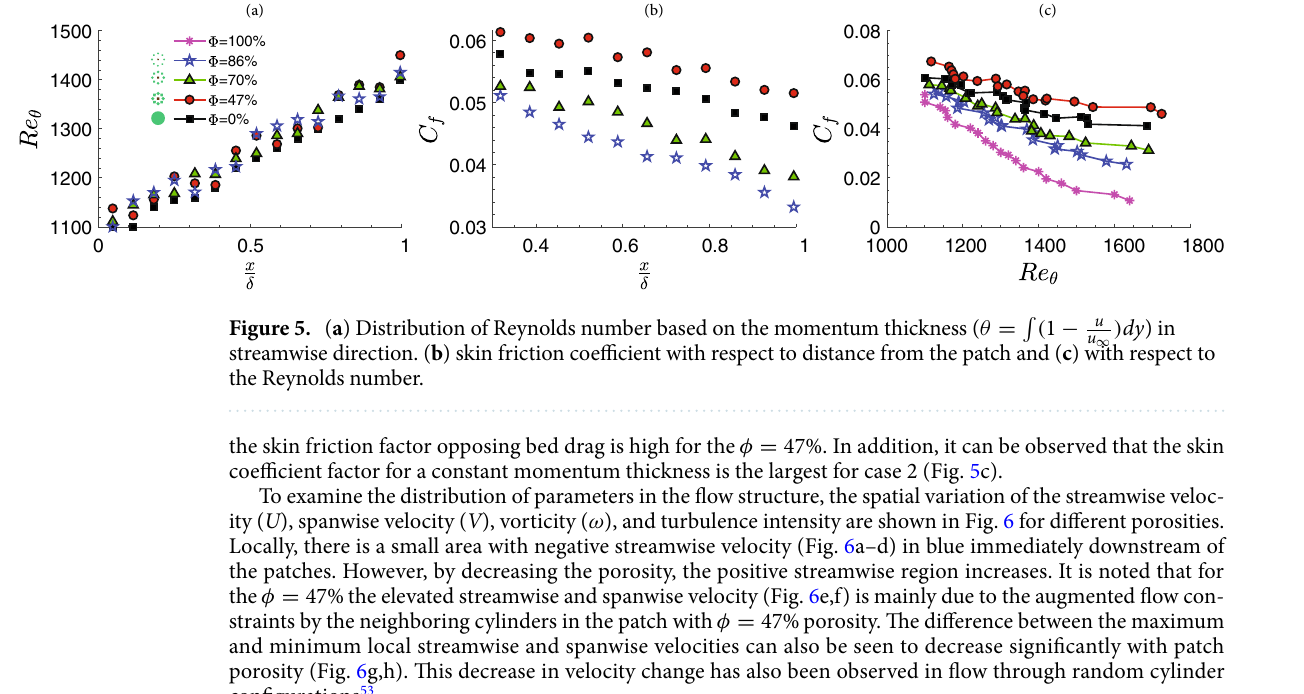
Figure 5. ( a ) Distribution of Reynolds number based on the momentum thickness ( θ = streamwise direction. ( b ) skin friction coefficient with respect to distance from the patch and ( c ) with respect to the Reynolds